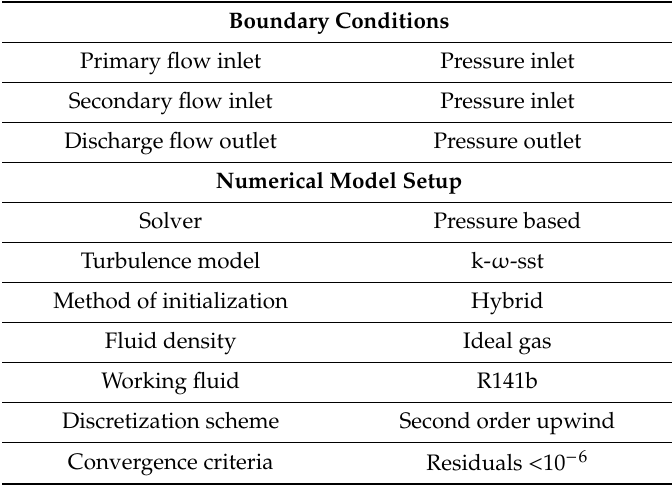
Table 3. CFD model setup summary. Table 3. Cont .